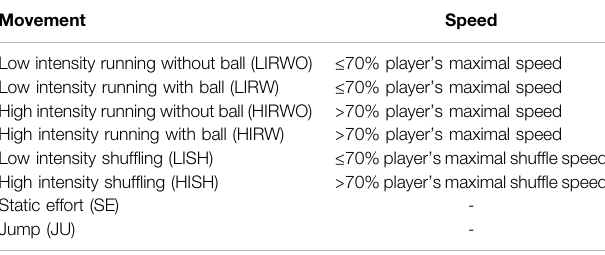
TABLE 1 | The seven movement categories (based on each player ’ s maximal speed) are used for categorization in the current study. Movement